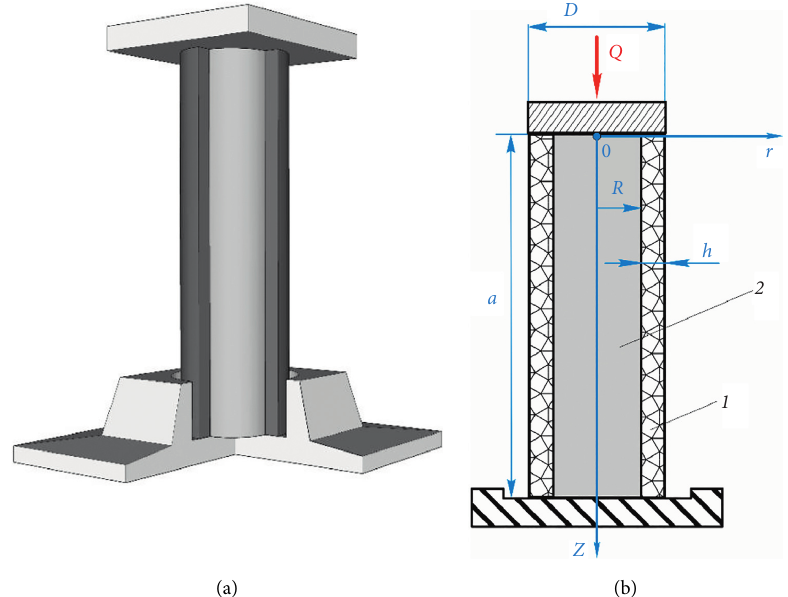
Figure 1: Scheme of two-layer concrete column: (a) general view; (b) design scheme ( 1 —shell of light PETF concrete; 2 —concrete